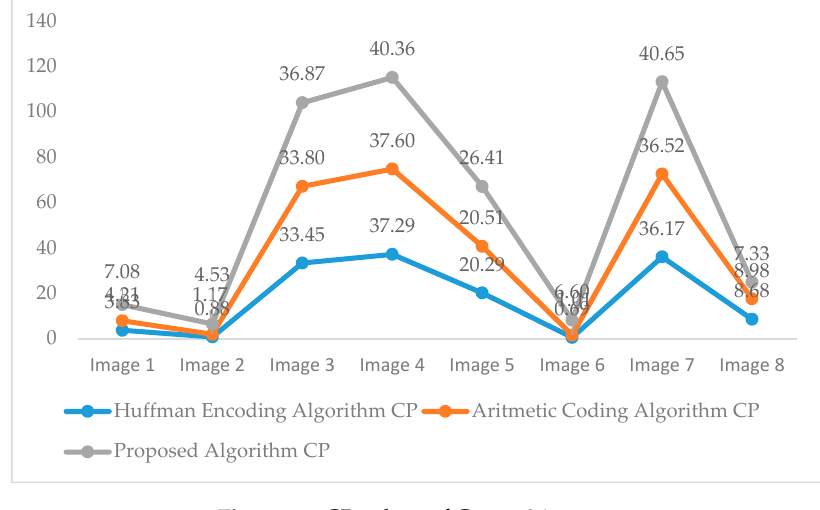
Figure 15. CP values of Group 2 images.